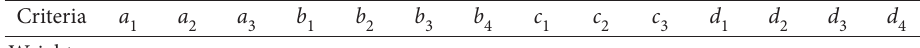
Table 8. Influential weights of DANP for each criterion obtained by α Criteria a